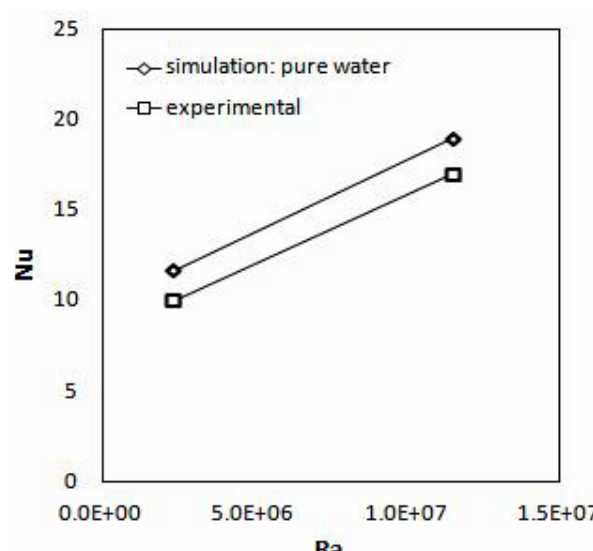
Fig. 4. Variation of Nusselt number with Rayleigh number for pure